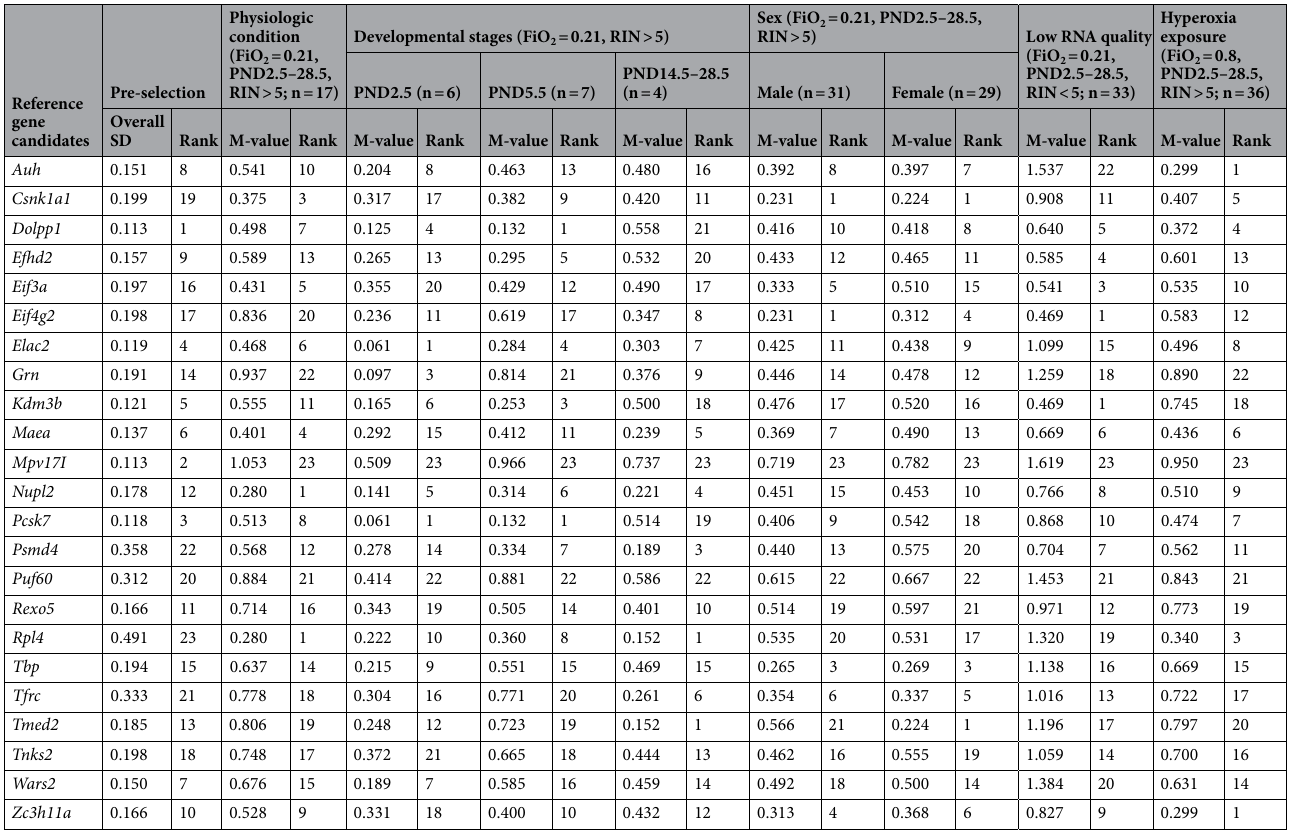
Table 2. GeNorm result represented with M-values and corresponding stability ranking for different analytic approaches compared with the